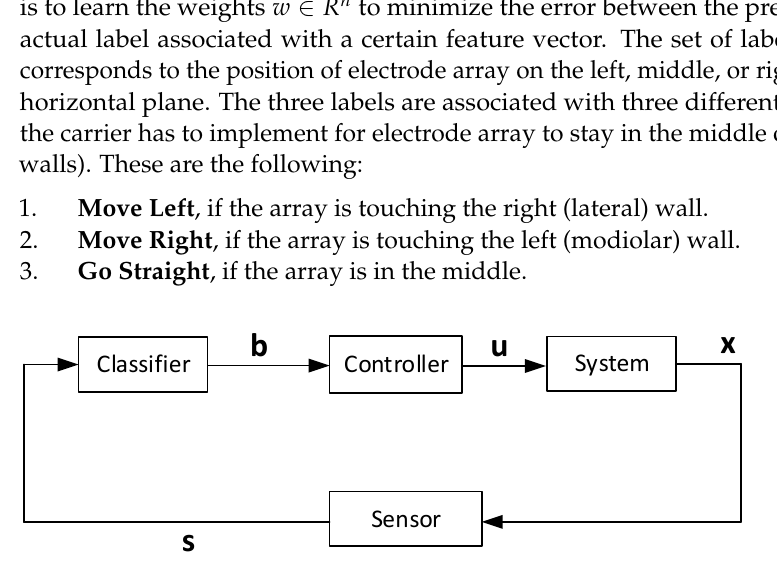
Figure 6. A classifier in a loop feedback control